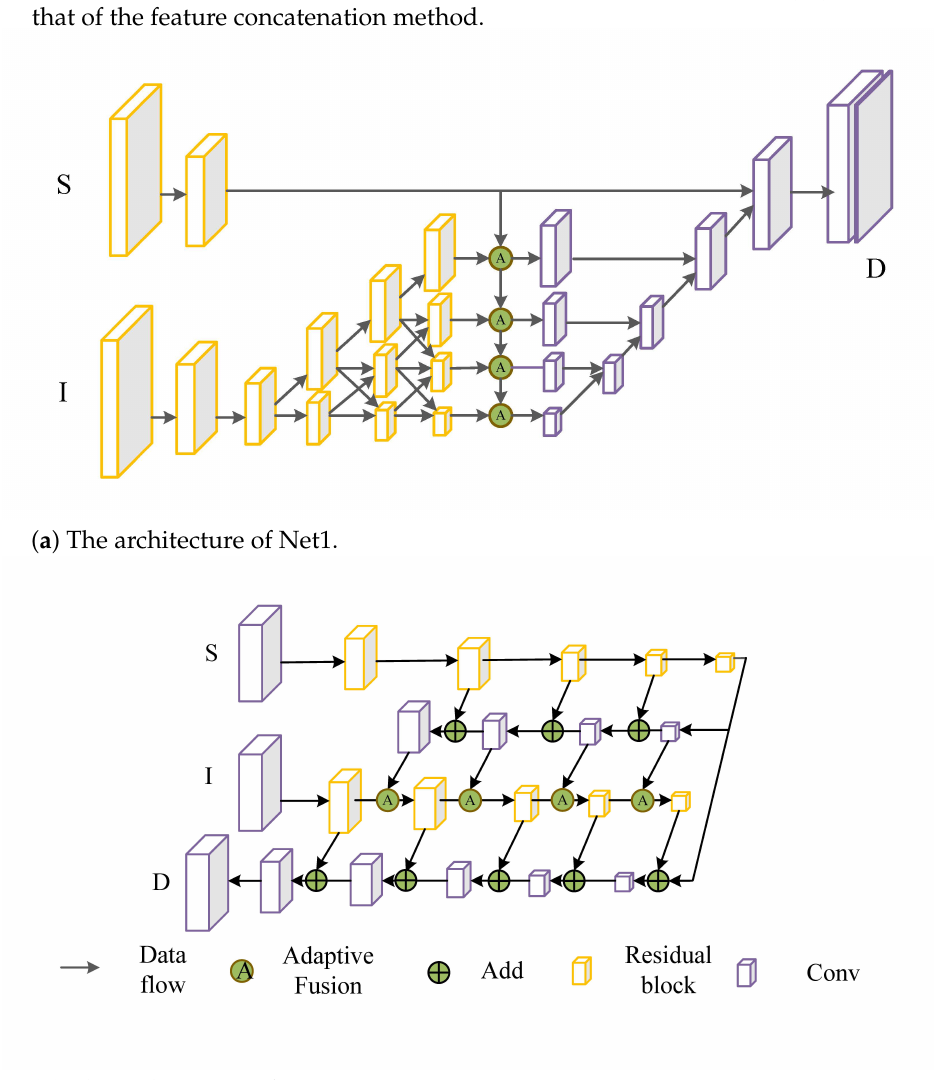
Figure 2. The network architectures: ( a ) the Net1 architecture; ( b ) the Net2